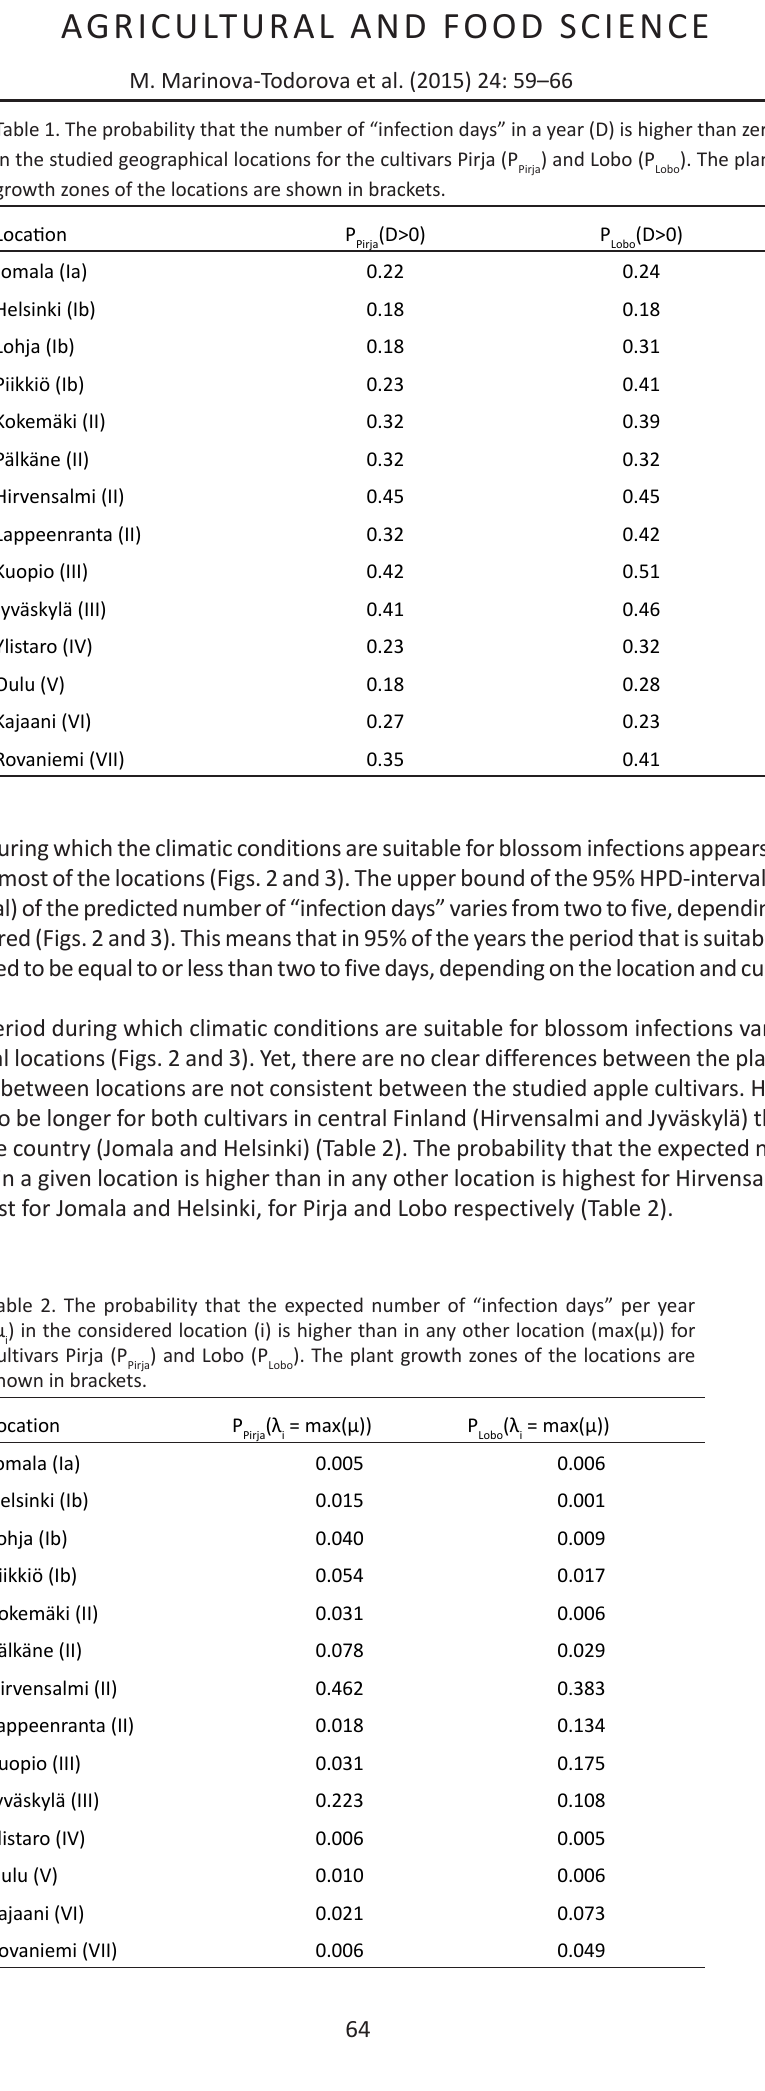
) and Lobo (P ). The plant Pirja Lobo